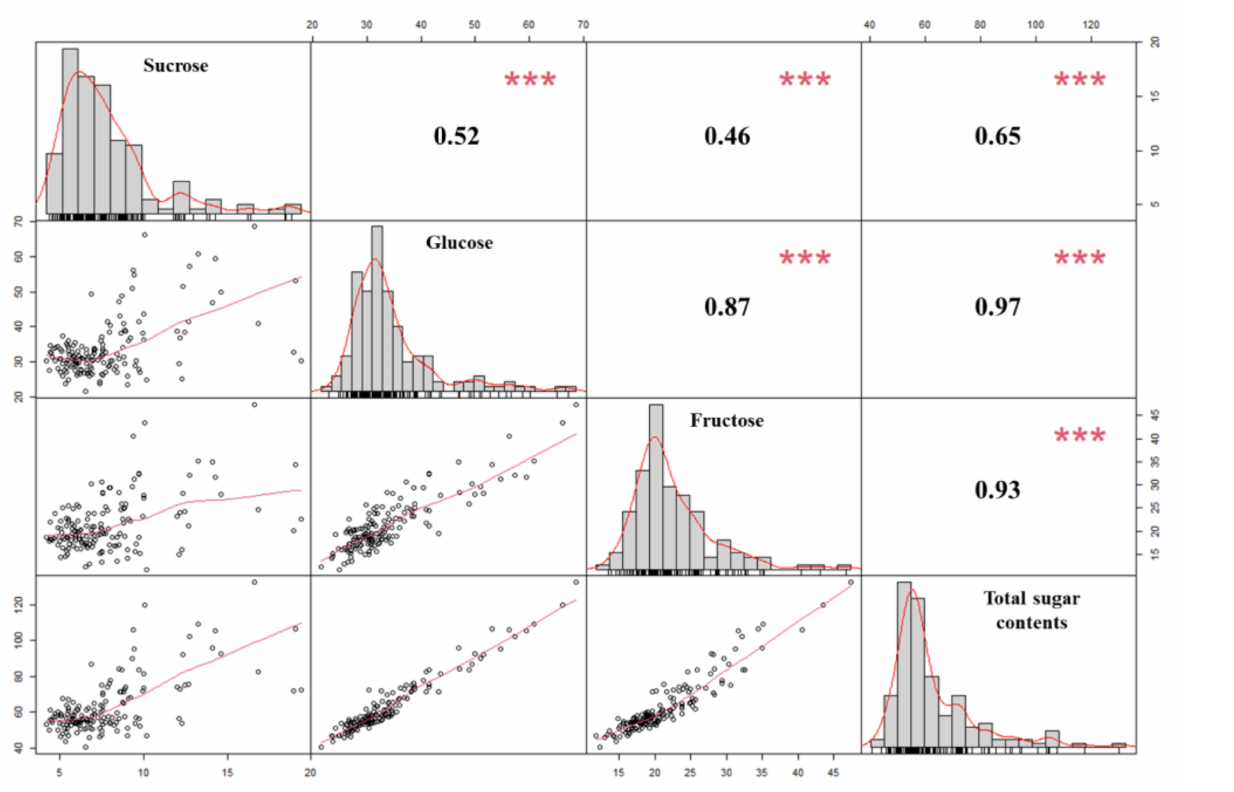
Figure 1. Overall correlation coefficients and frequency distributions among sucrose, glucose, fructose and total sugar content in 156 F 2 onion mapping population. Red asterisk *** indicate the significance at the levels of p <